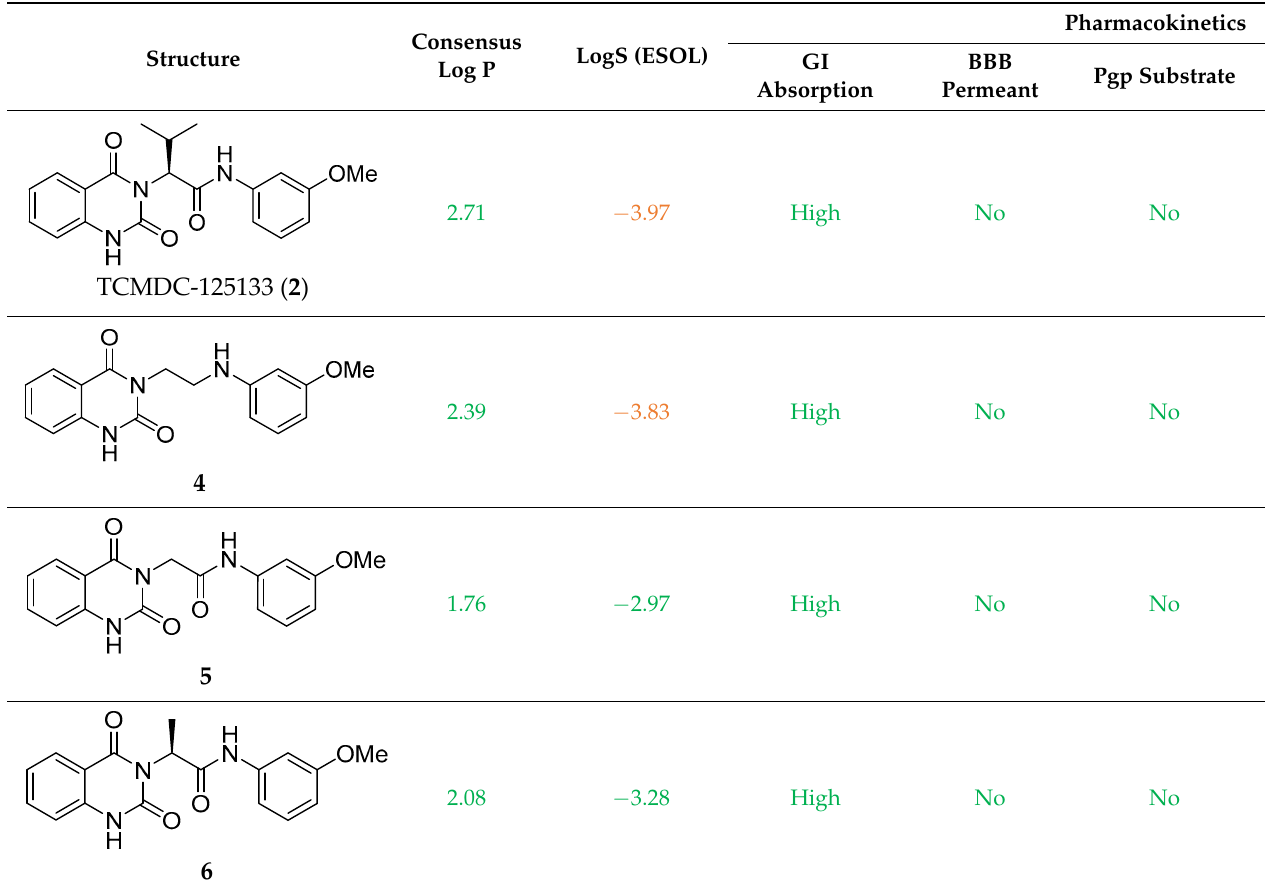
Table 1. SwissADME in silico calculation of TCMDC-125133 and other derivatives containing various side chains. Red font denotes unsuitable properties for a drug candidate, orange font denotes moderate suitability, and green font denotes a favorable profile.